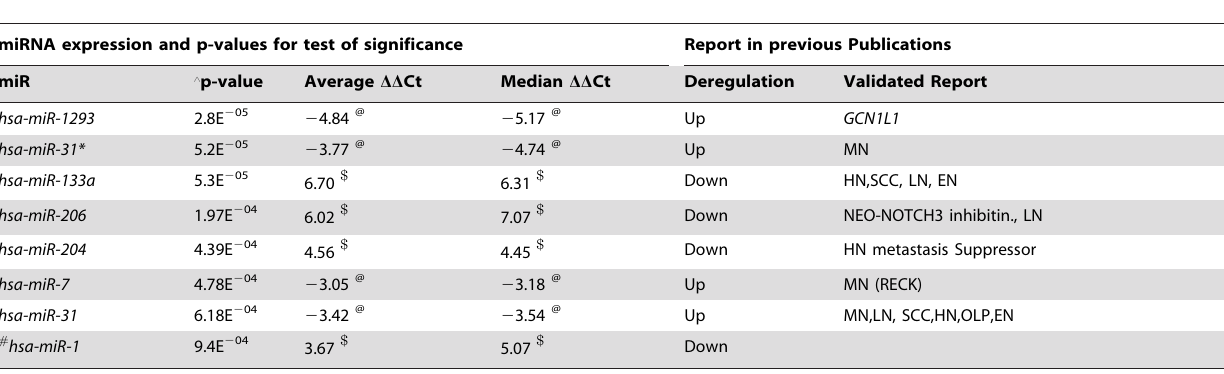
Table 5. Reported targets associated with 7 miRNAs significantly deregulated in 18 cancer samples.